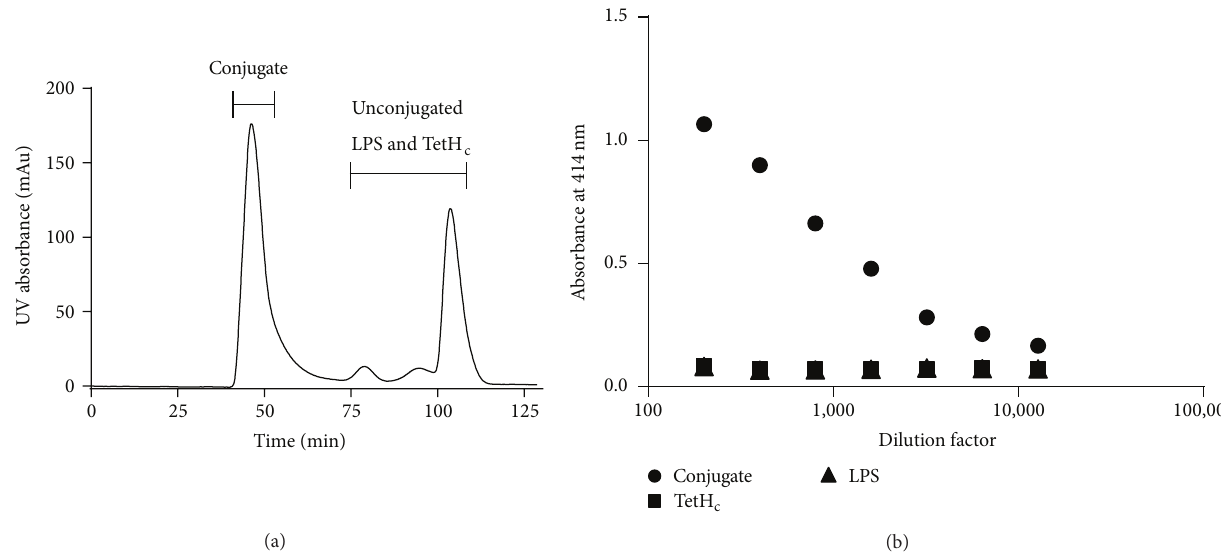
Figure 1: Conjugate analysis. FPLC trace detailing elution of the TetH c -LPS conjugate following synthesis (a). The recovered conjugate fraction ( ∙ ) was analysed by capture ELISA (b) with comparison to unconjugated LPS ( 󳵳 ) and unconjugated TetH c ( ◼ ). Only the conjugate, which contains both antigens in a single molecule, provided a positive result.